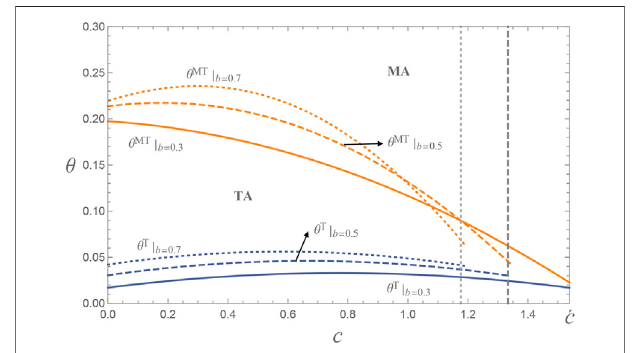
FIGURE 2 | Optimal channel strategy. ( a (cid:1) 1 )